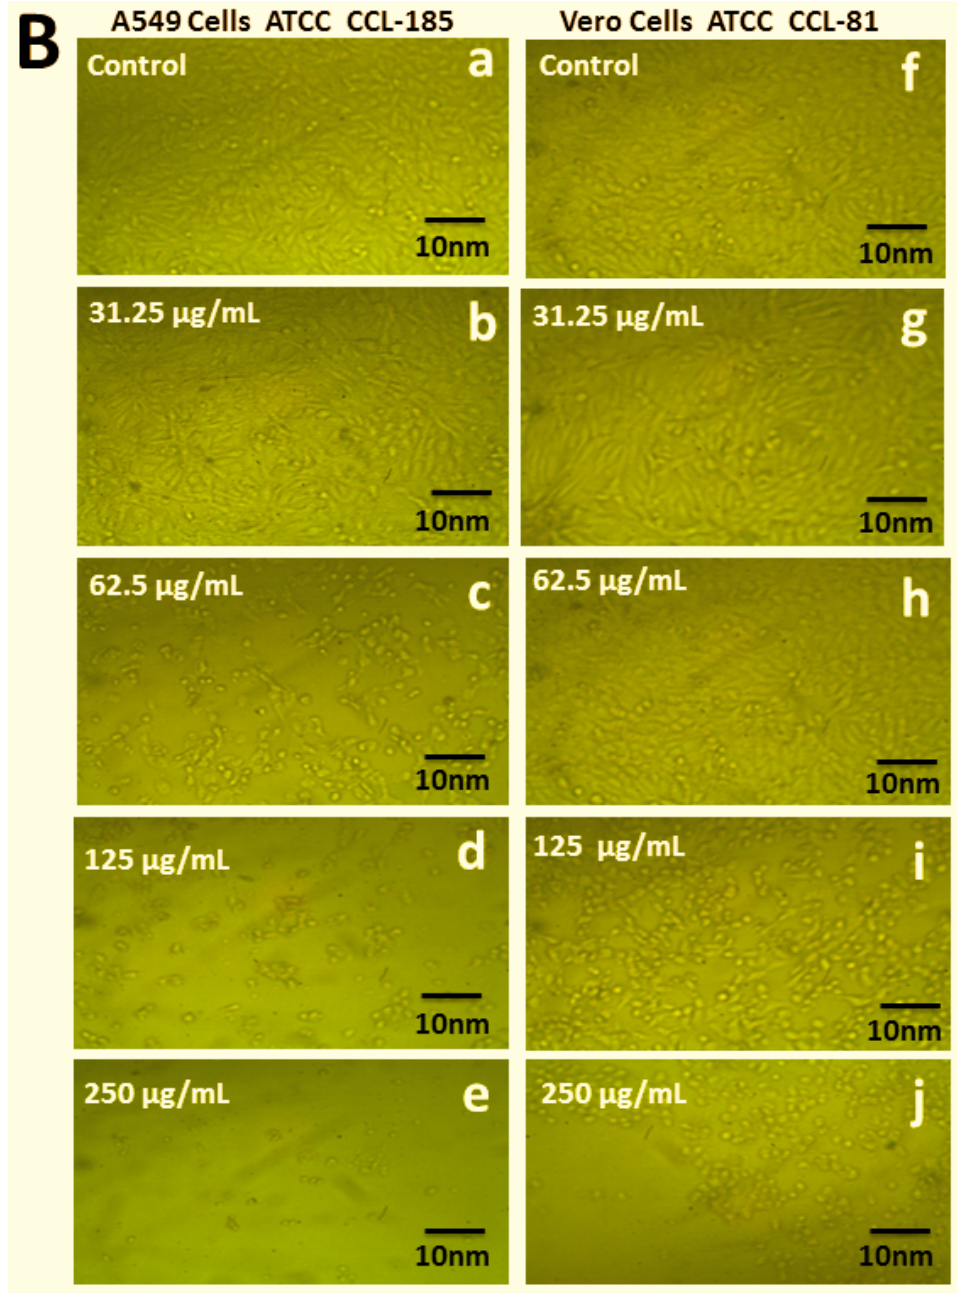
Figure 11. ( A ) Percentage of viable Vero and A549 cells treated with different concentrations of SRLe- α Fe 2 O 3 at 48 h in MTT assay. Numerical data are reported as the mean ± SD ( n = 3). ( B ) In vitro cytotoxicity of NPs on ( a – e ) A549 and ( f – j ) Vero cell lines (scale bar =10 μ m).